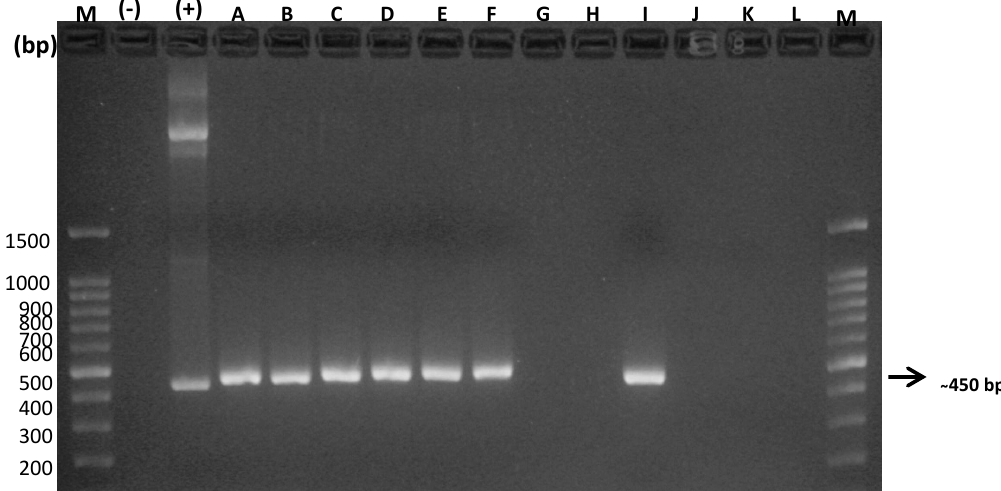
Figure 3. Amplification products obtained by PCR in a general assay for DNA samples obtained from serum of domestic cats. M: Molecular weight marker; ( − ): Negative control; ( + ): Positive control; bp: base pairs; A → L: domestic cats analysed in this